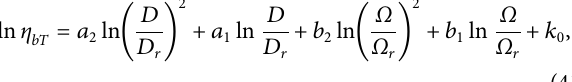
Frontiers in Energy Research |